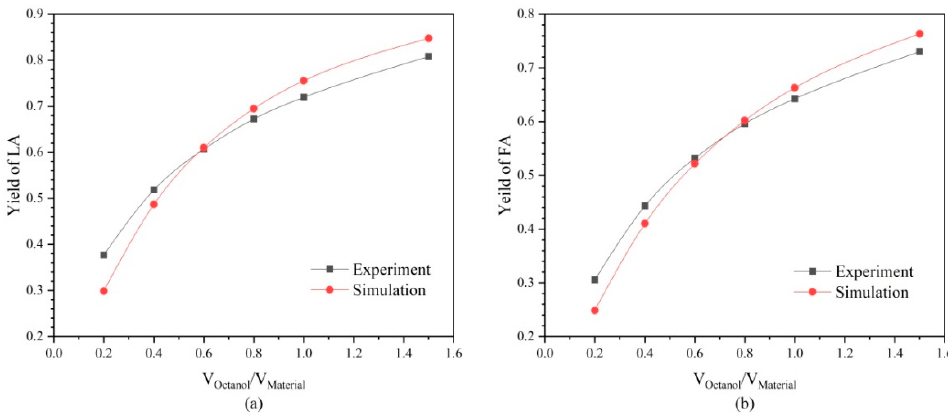
Figure 11. Comparison of experimental and simulated yields of ( a ) LA and ( b ) FA.